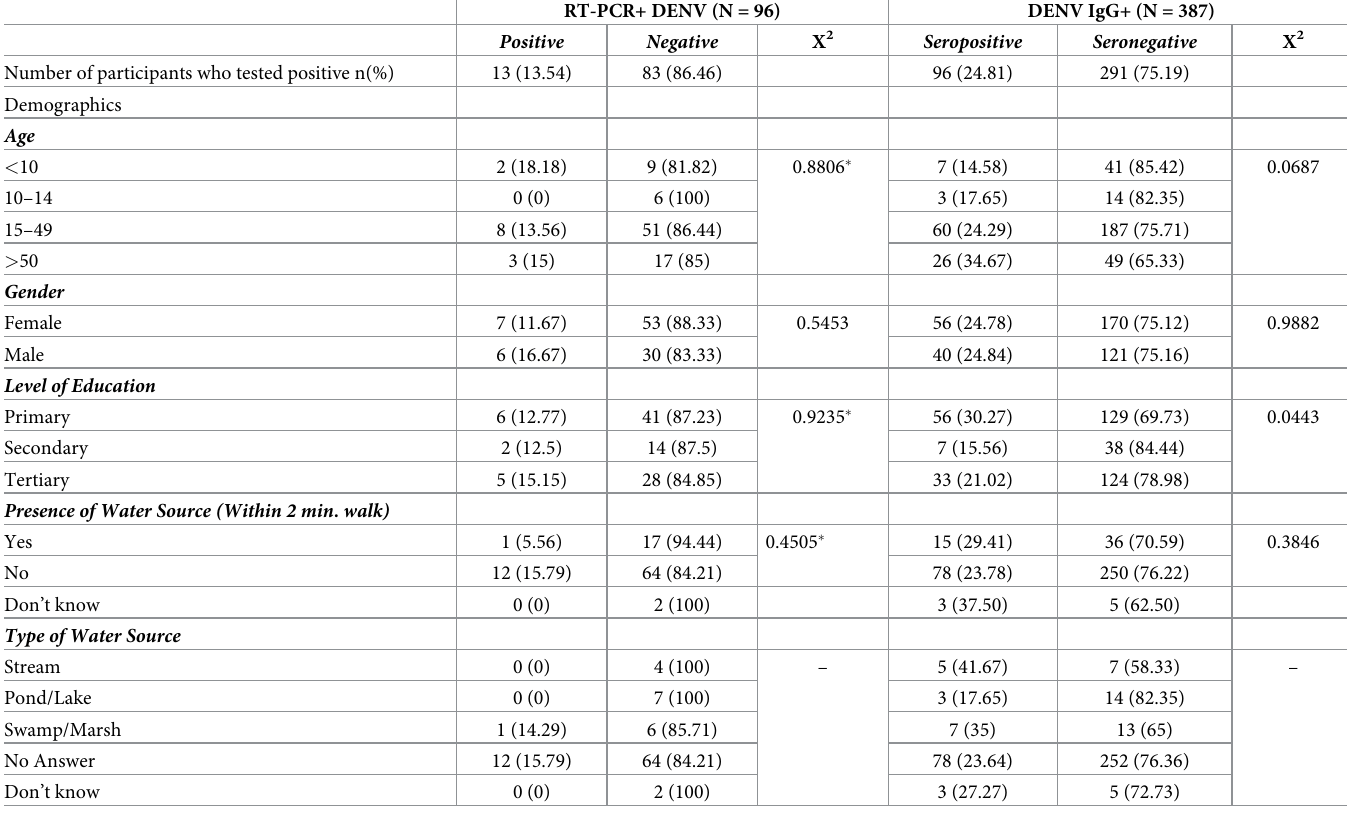
Table 1. Sociodemographic characteristics of study population and association with DENV infection outcomes.